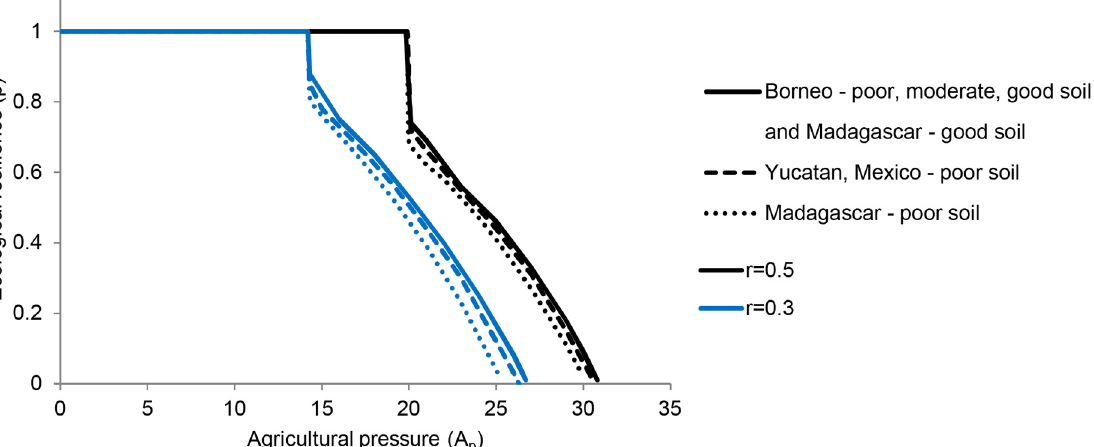
Fig 6. Ecological resilience of the forested stable state as a function of agricultural pressure. The ‘ ecological resilience ’ is the proportion of forested land that can be converted to agriculture without pushing the socio-ecological system into the deforested stable state. Results are shown for two different values (0.3 and 0.5) of the local recruitment rate parameter ( r